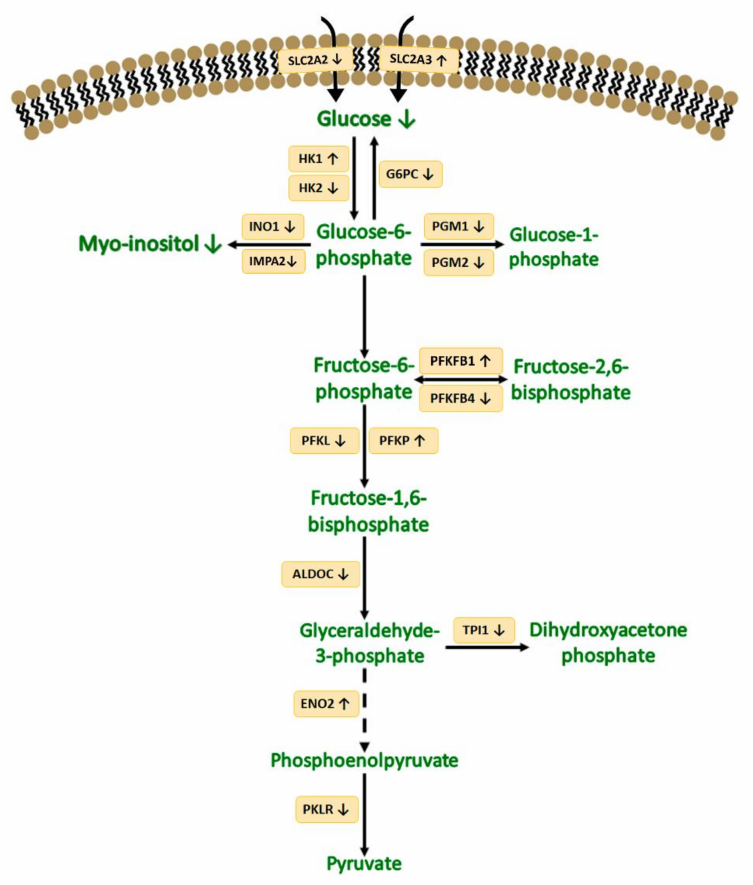
Figure 6. Scheme of the glycolysis pathway and the transcripts controlling its